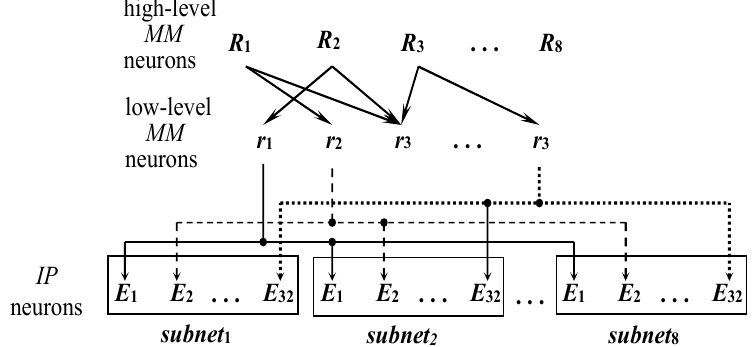
Figure 4. The architecture of the control mechanism of memory manipulation (MM) neurons.